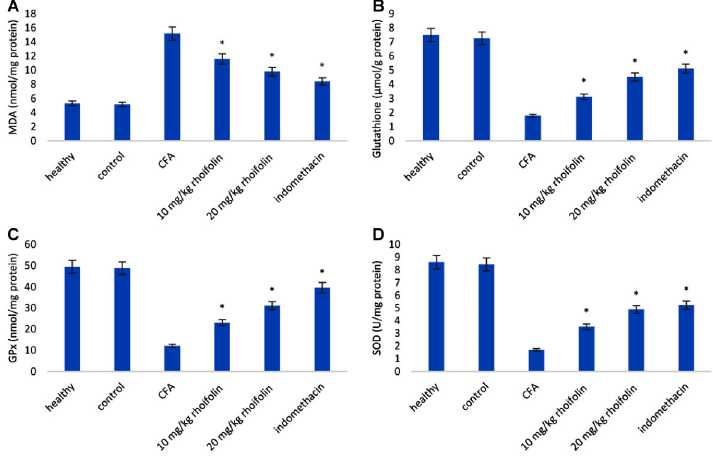
Figure 3. Effect of rhoifolin treatment on antioxidant marker enzymes. Data are reported as means ± SE. *P p 0.05 compared to complete Freund ’ s adjuvant (CFA)-induced group (ANOVA). MDA: malondialdehyde; GPx: glutathione peroxidase; SOD: superoxide